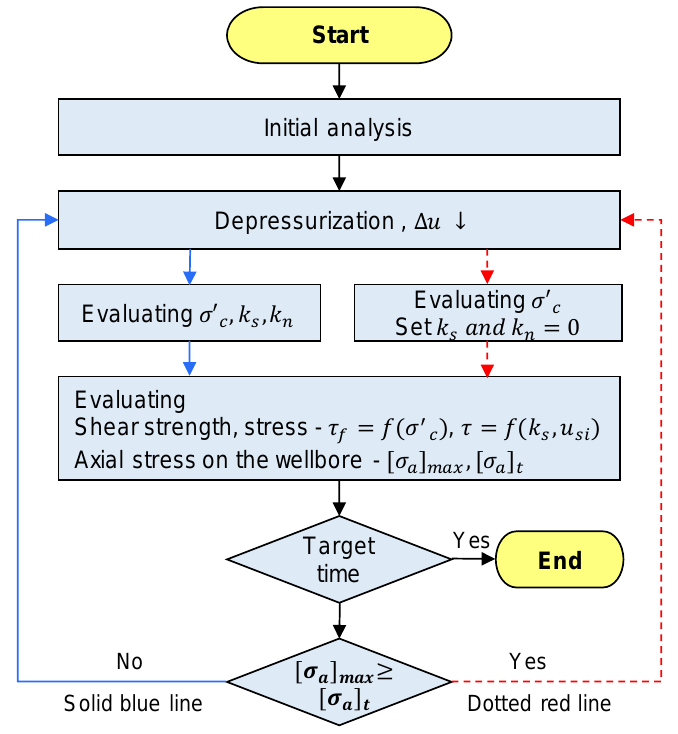
Figure 7. Algorithm for well-bore stability analysis of simulator.